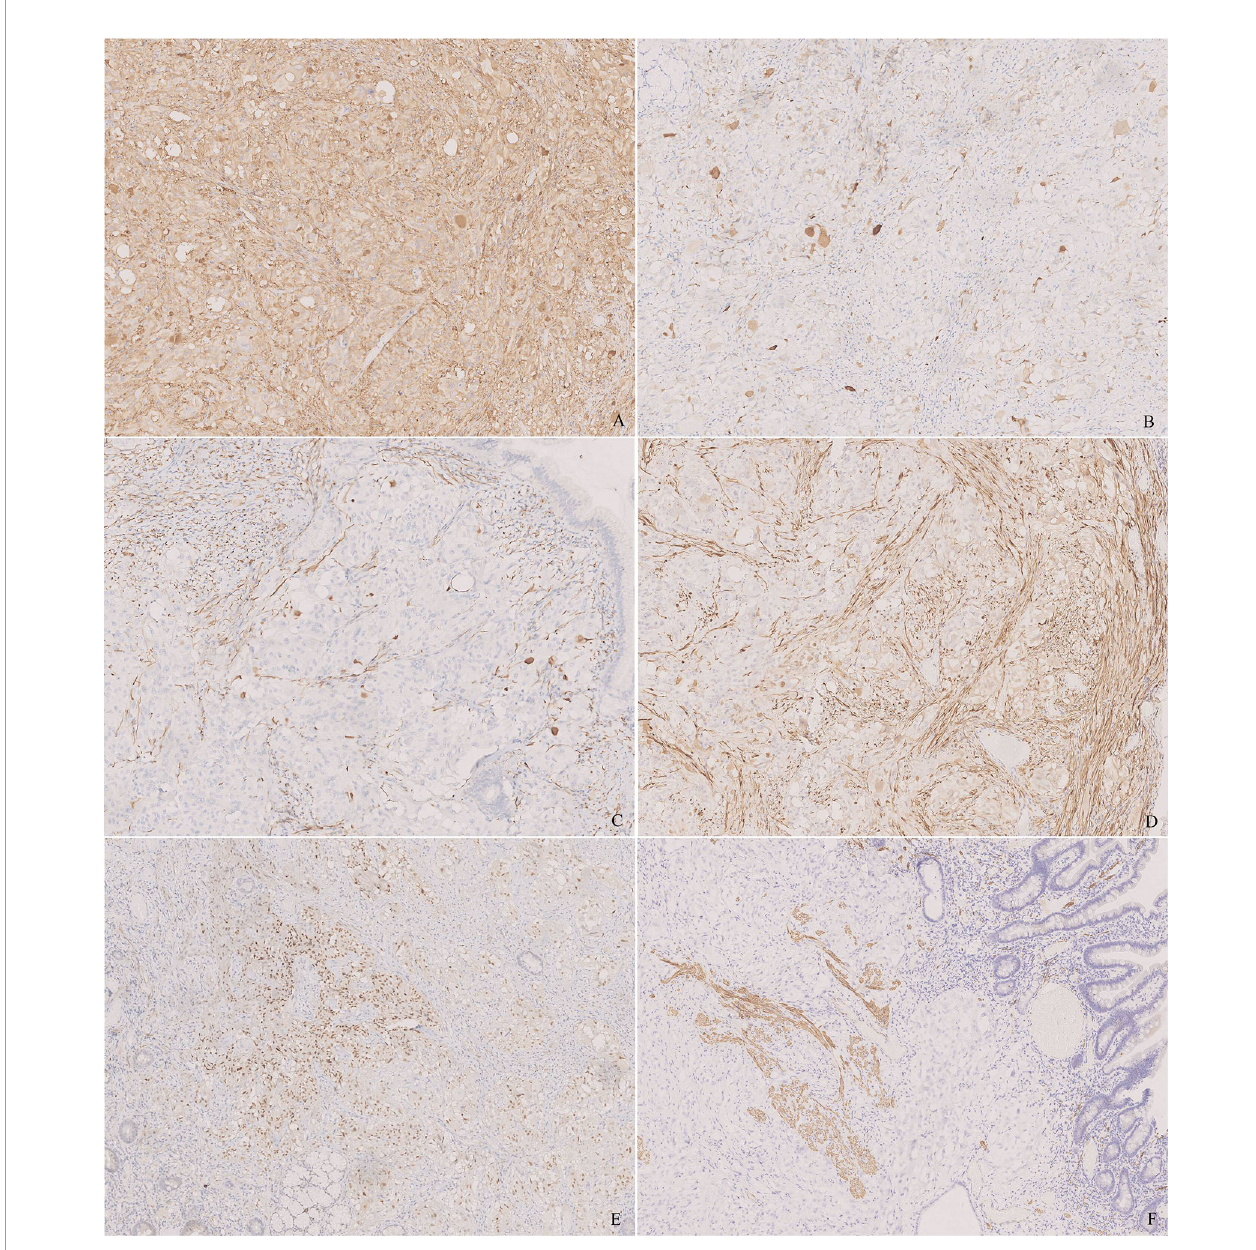
FIGURE 3 | Immunohistochemistry of the tumor. (A) Synaptophysin (Syn) was diffusely positive for epithelioid cells and highlighted the ganglion-like cells. (B) Chromogranin A (CgA) was positive for epithelioid cells and highlighted the ganglion-like cells, but the number of positive cells was less than that in Syn. (C) Neuro fi lament (NF) stained some ganglion-like cells and neoplastic spindle cells. (D) S-100 stained the sustentacular cells around the epithelioid cells and the neoplastic spindle cells. (E) Progesterone receptor (PR) was positive in some epithelioid cells. (F) Desmin stained the muscularis mucosa, which displayed that the tumor in fi ltrated the lamina propria. [ (A – F) ,